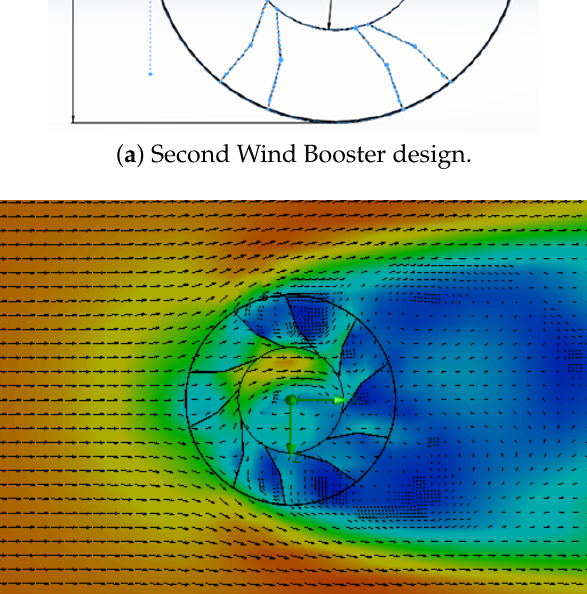
Figure 8. Second Wind Booster